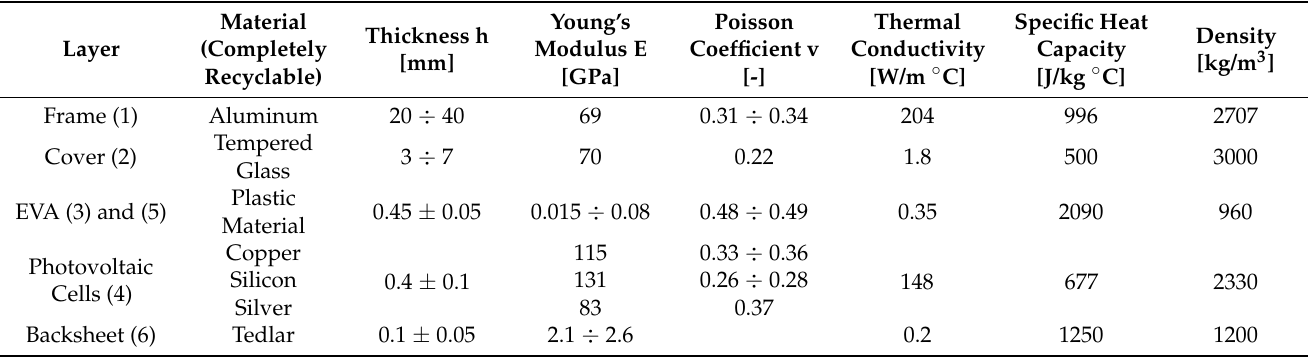
Table 2. Recyclable materials for PV panel components and their physical and mechanical character-